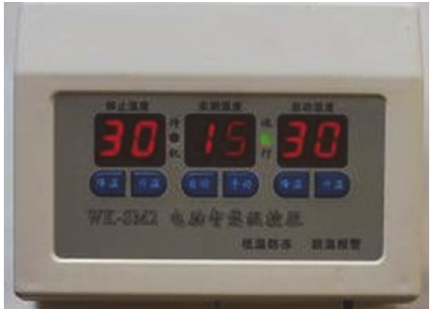
Figure 3: WL-8XZ temperature controller.